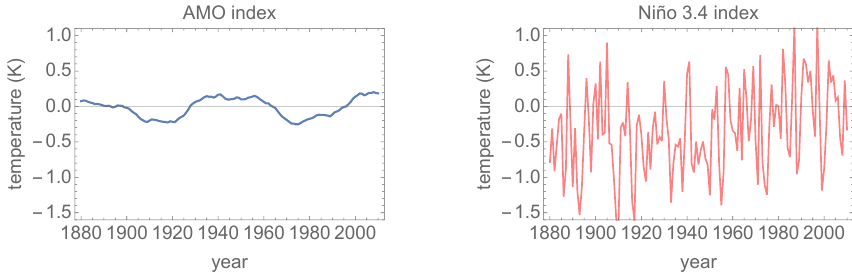
Figure 4. Left panel: the AMO index with annual resolution 1880–2010CE. Right panel: the Niño 3.4 index.